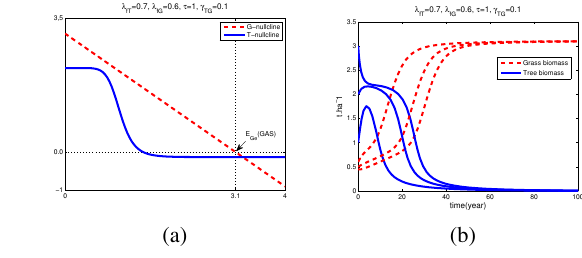
Fig. 15: (a) and (b) show that equilibrium E